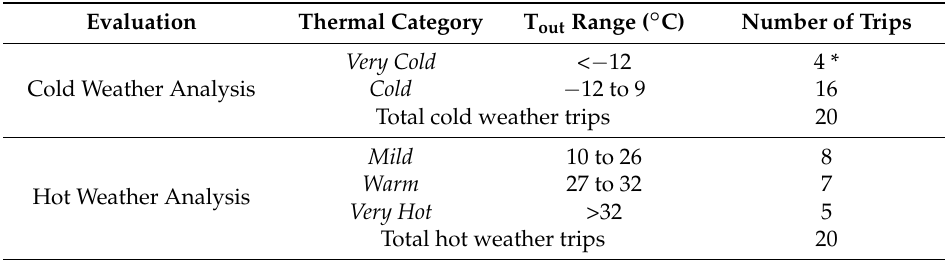
Table 1. Summary of field-monitoring trips completed with thermal categories based on average outside air temperature range recorded during each